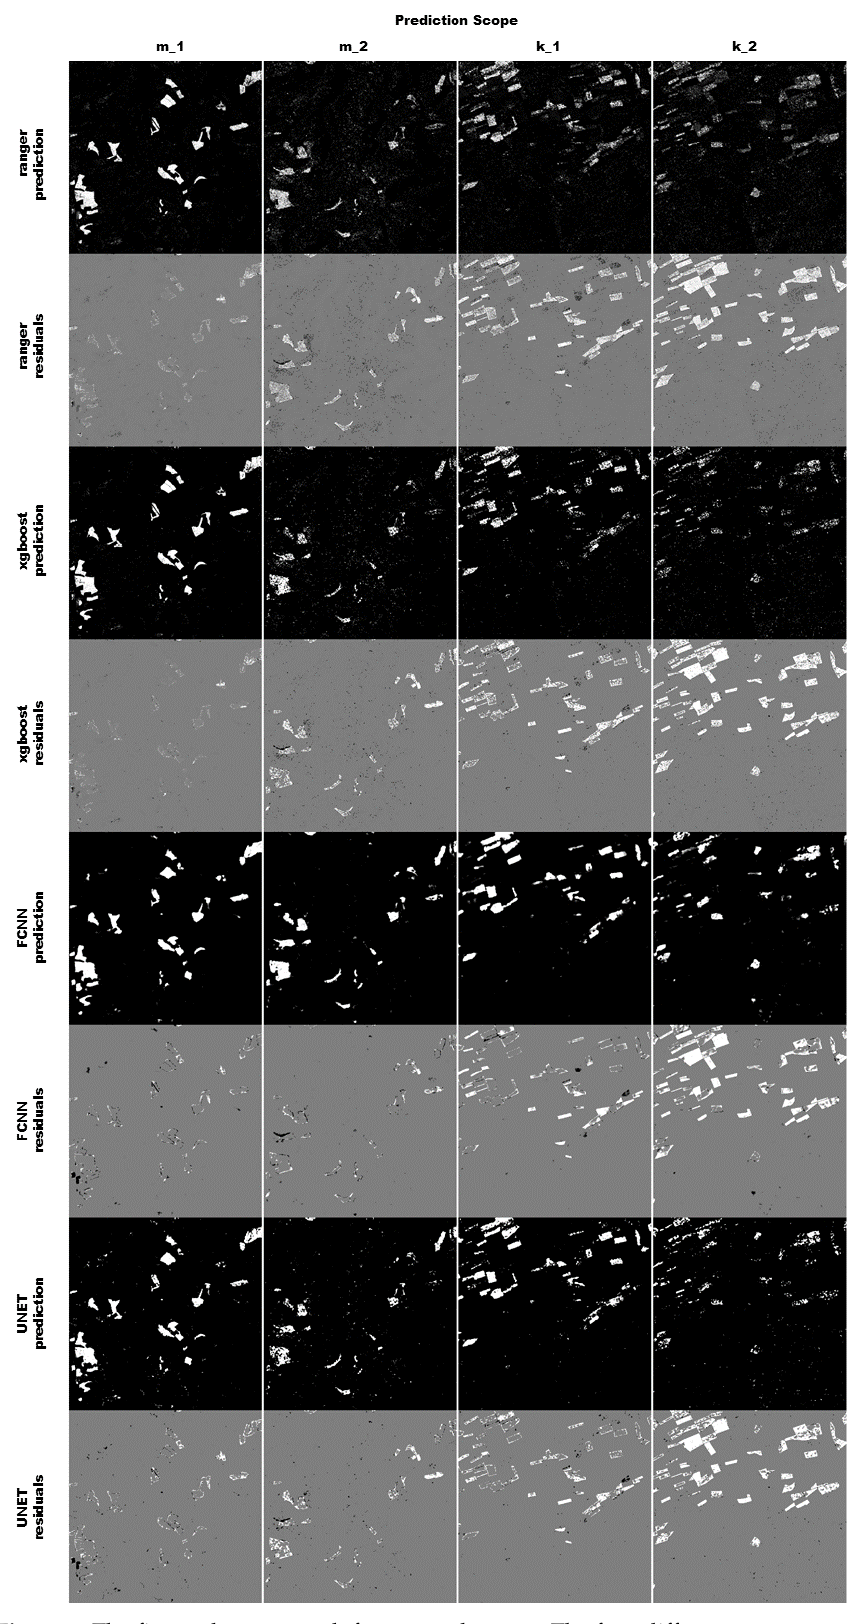
Figure 8. The figure shows a result for a complete run. The four different scopes are shown in the columns, while the model predictions and residuals are shown in the rows. The prediction pixels are colored in white (predicted to be maize) and black (predicted to be not maize). The residuals are colored in white (false negative), black (false positive) and grey (true positive or true